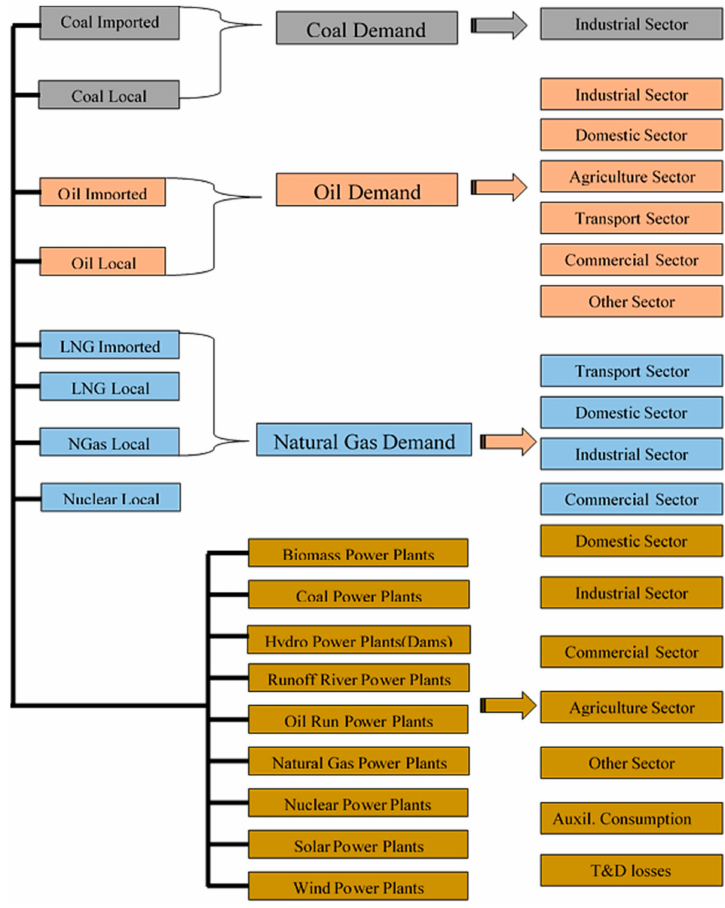
Figure 5. The reference energy system of the Pak-TIMES